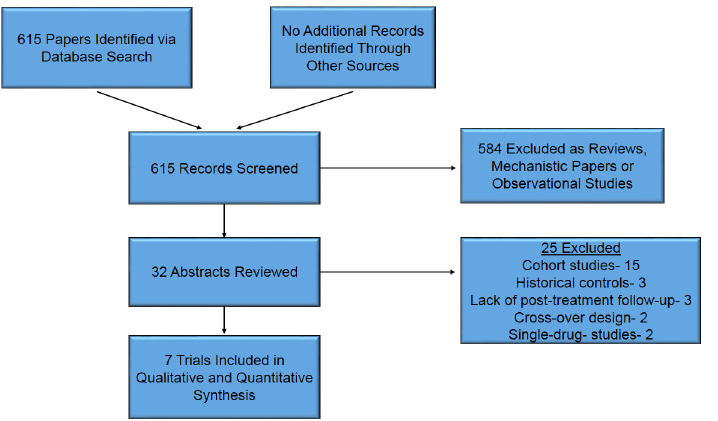
Fig 1. Identification of Trials for Inclusion in Review. Process and criteria by which papers were selected for inclusion in meta-analysis. Following exclusion of papers not relevant to the current study and those that met exclusion criteria, a total of 7 papers were included in the